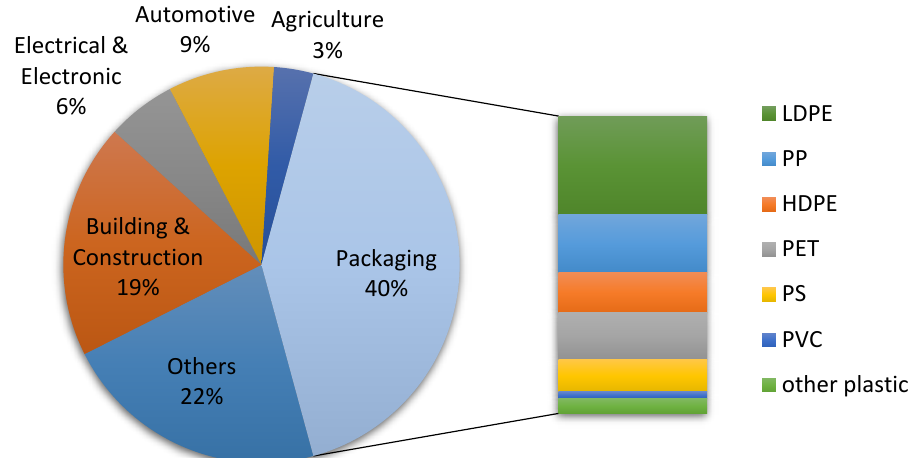
Figure 1. Fields of application of plastic materials and polymer types predominately used in packaging. The respective share of the different polymers is derived from a graphic illustration of the polymeric composition of plastic packaging in Europe [11]. Abbreviations used: LDPE (low-density polyethene), PP (polypropene), HDPE (high-density polyethene), PET (polyethylene terephthalate), PVC (polyvinyl chloride), PS (polystyrene), PA (polyamide),